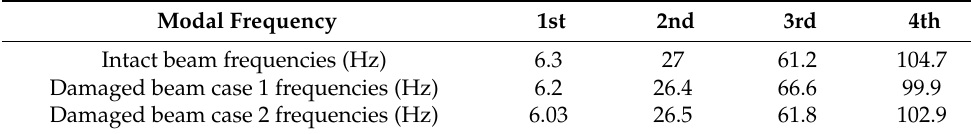
Table 11. Measured natural frequencies of the test beam.